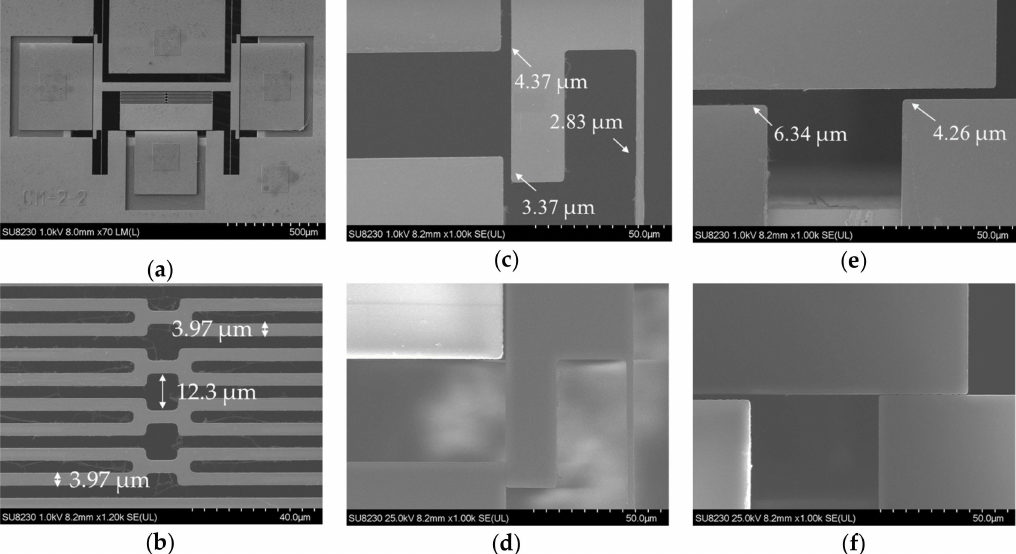
Figure 8. Detailed SEM micrographs with measurements of the fabricated translational MEMS platform: ( a ) final translational MEMS platform; ( b ) serpentine spring; ( c ) lateral actuator and spring’s fabricated dimensions; ( d ) lateral actuation during high power imaging; ( e ) gap closing actuator’s fabricated dimensions; ( f ) gap closing during high power